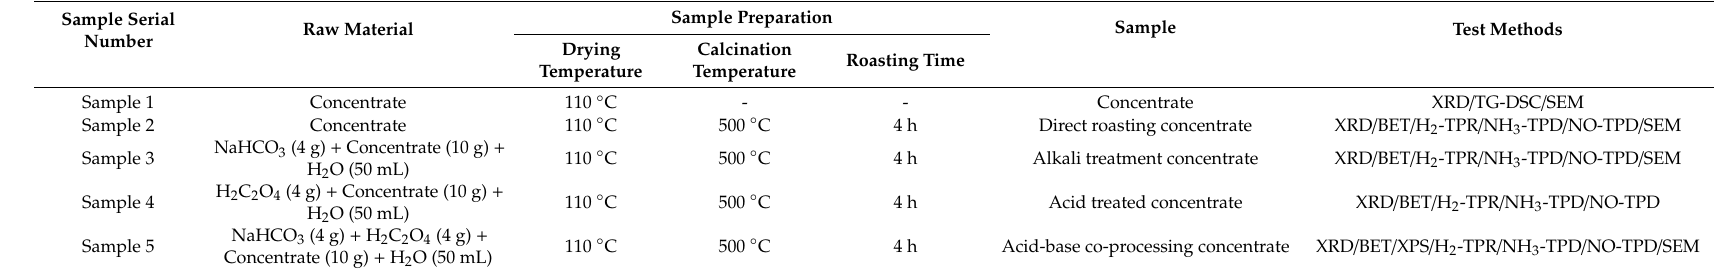
Table 2. Preparation procedure and test plan of rare earth concentrate